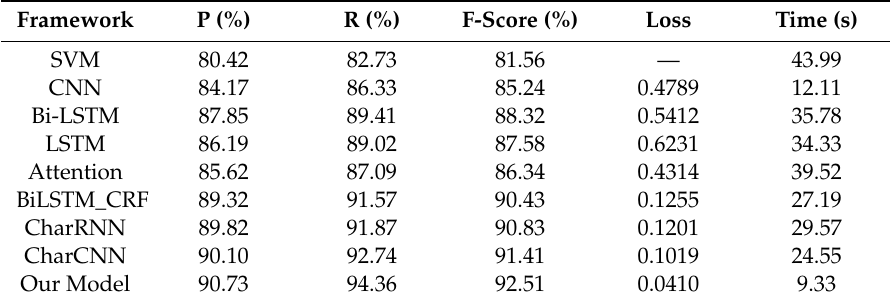
Table 6. Comparison with shallow machine learning and traditional named-entity recognition